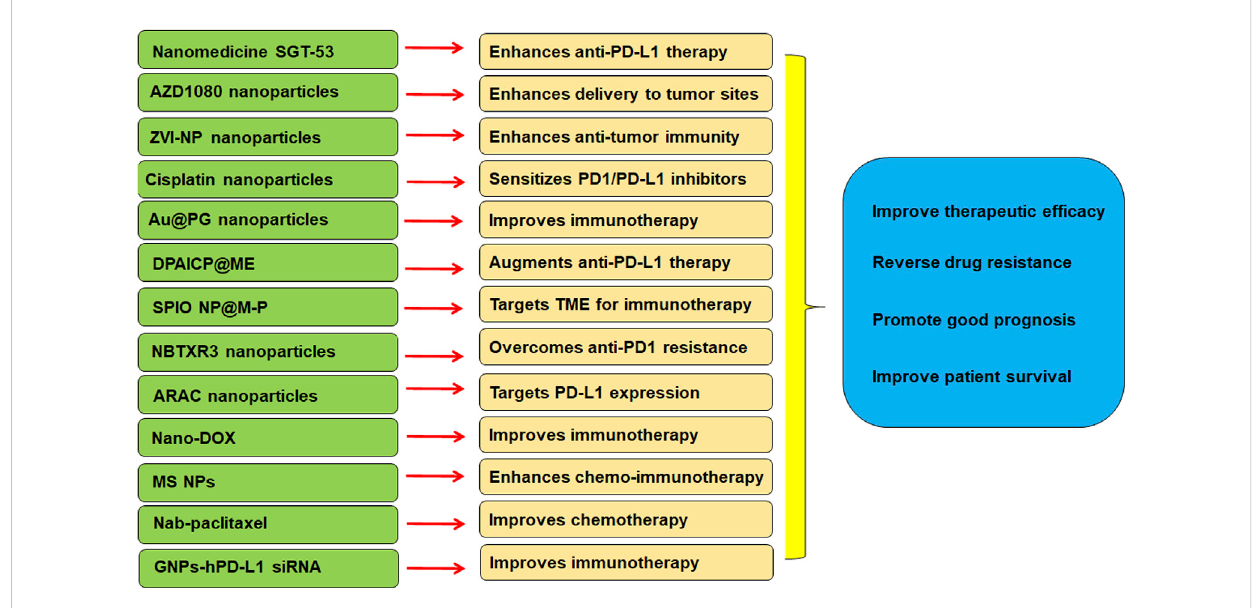
The role of nanoparticles in regulation of TME and immunotherapy in lung